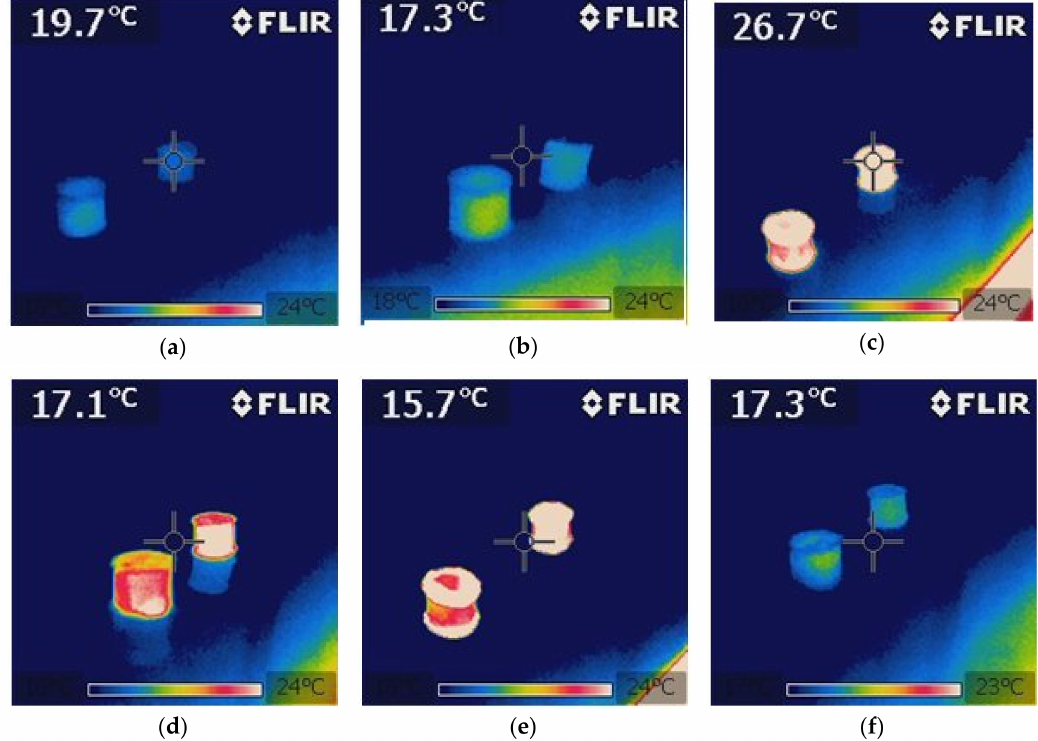
Figure 13. Thermograms of heating and cooling samples with pure PCM and with composite PCM and coke recyclate. ( a ) steady state before heating, ( b ) initial heating phase, ( c ) steady state after sample heating, ( d ) start of sample cooling, ( e ) start of sample cooling, ( f ) the final stage of cooling the